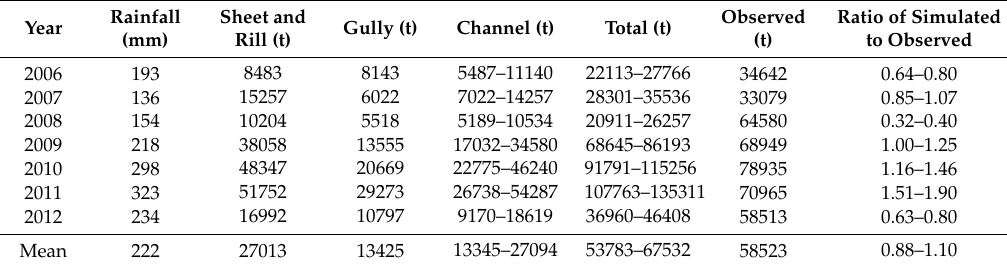
Figure 9. Total sediment removed from the Los Laureles Canyon traps in the United States versus total annual precipitation between removal events from 2005 to 2012. The uncorrected amount of sediment removed is in black and the load corrected for trap efficiency is in grey. Annual precipitation is from the San Diego Brownfield station. Modified from Biggs et al. [33]. Table 6. Simulated annual sediment yield and total observed (in tons) at the watershed outlet by the erosion process. The range values for channel contribution and total yield assumes channel erosion is 25% (minimum value) and 40% (maximum) of the total simulated results from AnnAGNPS.